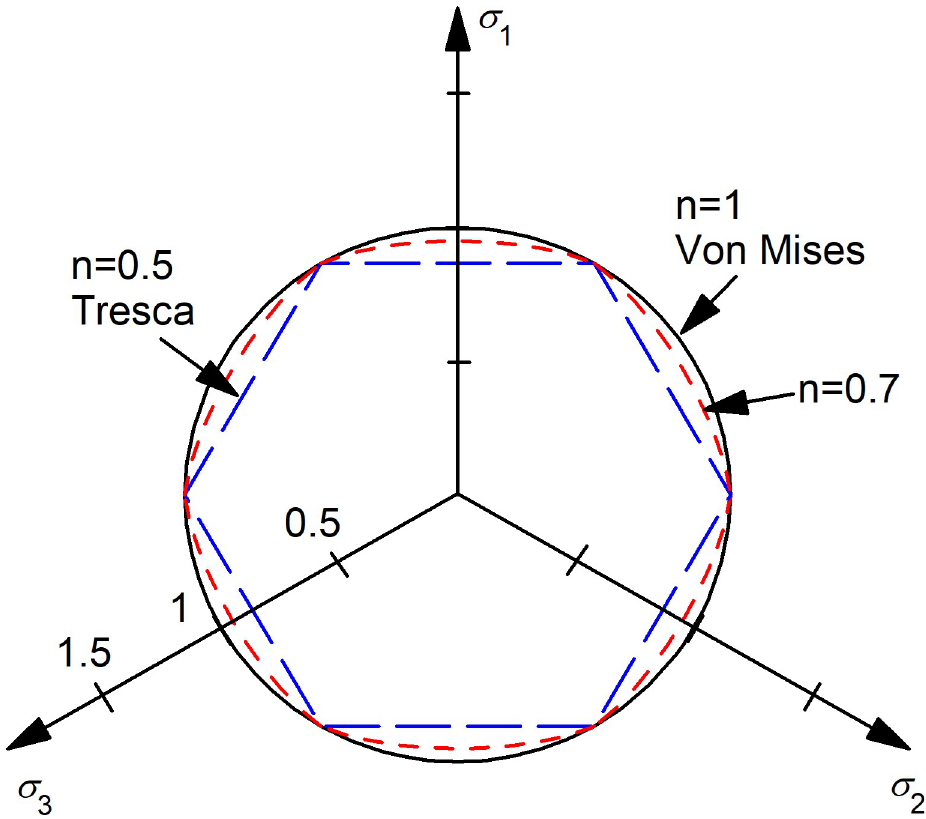
Fig 12. Influence of non-linearity for incompressible materials: Deviatoric plane section of the yield surface.